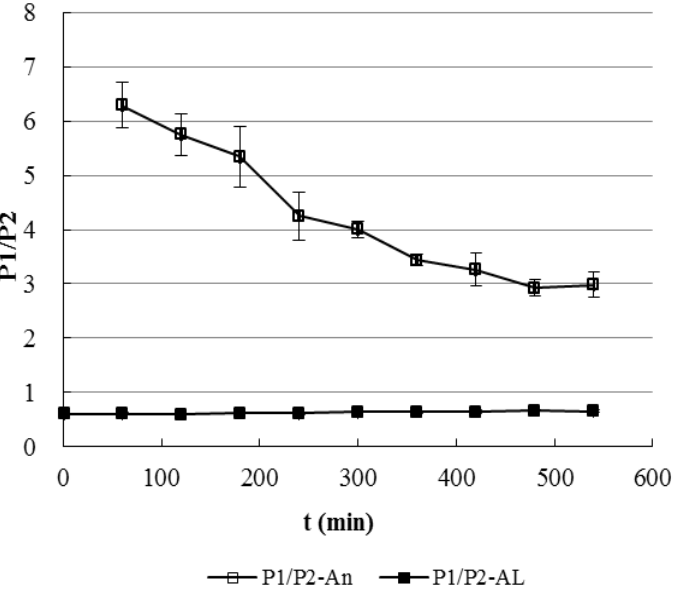
Figure 8. Real-time Monitoring of the peak area ratio of P1/P2 in the Reactions of Andro and AL-1 with GSH (n = 3). P1/P2-An and P1/P2-AL represented P1/P2 ratio in the Andro and AL-1 reaction system,